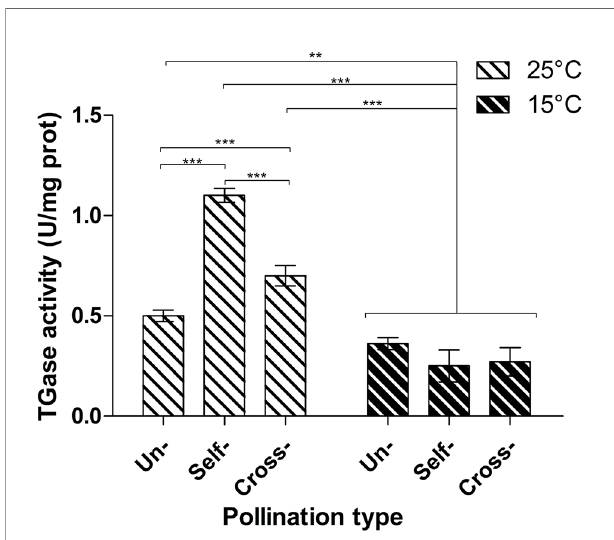
FIGURE 2 | Microplate assay for TGase activity. TGase activity was tested in unpollinated, self-pollinated and cross-pollinated pistils at 25°C and at 15°C. TGase activity is expressed as units (U) of speci fi c activity per mg of protein. Means ± S.D. of three experiments analyzed in triplicate are reported. The data were analyzed by one-way ANOVA and Tukey ’ s post-test. A p value < 0.05 was regarded as statistically signi fi cant. **p < 0.01. ***p <